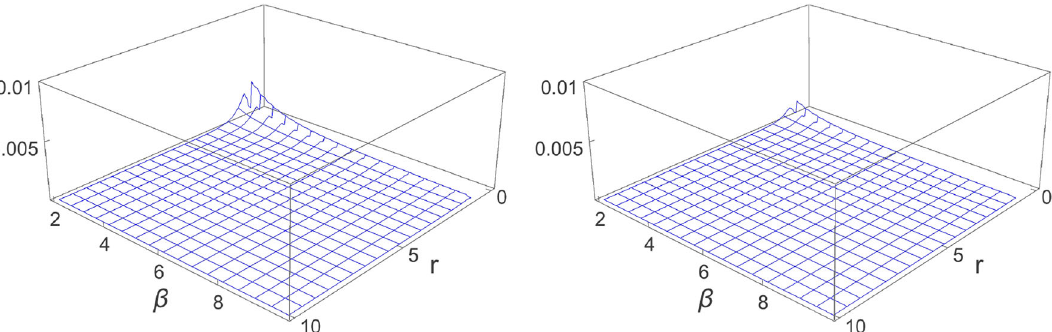
Fig. 5 The ratio | ∂ r ∗ P c | / | P RN | for the two eigenvectors of the matrix V for the EBI charged black holes is presented with respect to r and β . We assume here Q ∗ = 0 . 3 and l = 2. Those values are chosen to